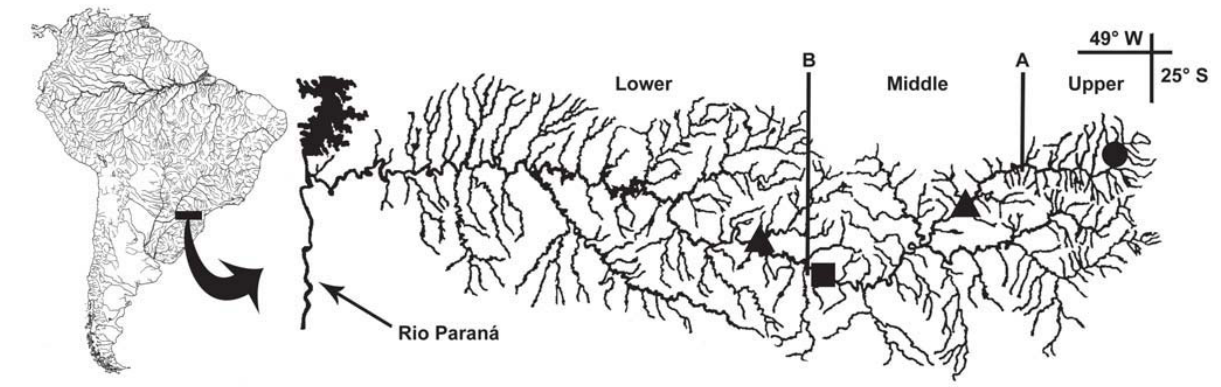
Fig. 6. Distribution of Rineloricaria langei (circle) and Rineloricaria maacki (square: holotype; triangles: paratypes) in rio Iguaçu basin. One symbol may represent more than one collecting locality. Vertical bars indicate biogeographic barriers of rio Iguaçu according to Ingenito et al. (2004) (A: Salto Caiacanga falls; B: Salto Grande falls).